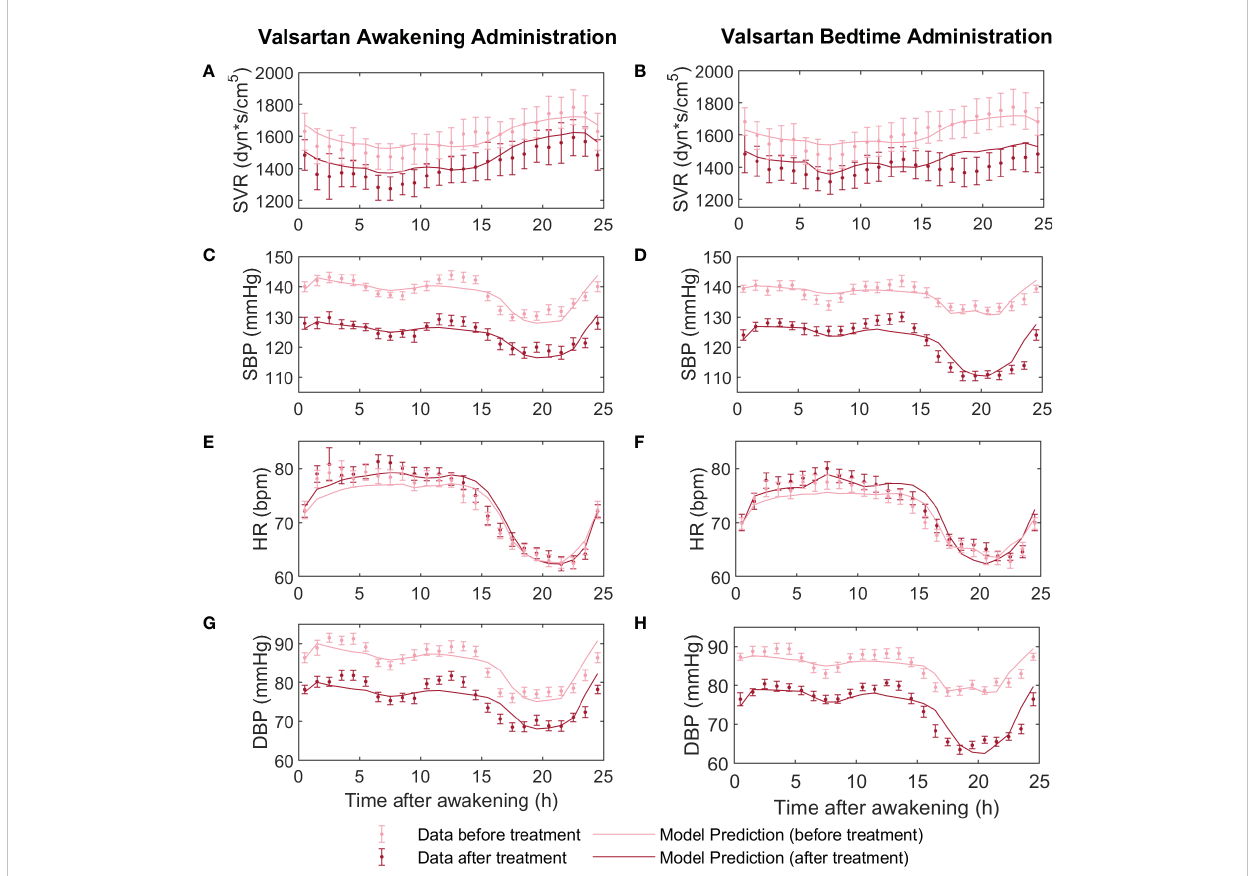
FIGURE 1 Fitting models to data before and after valsartan treatment at awakening (on the left) versus at bedtime (on the right). Before-treatment data from AM and PM administration groups were fi tted independently, to a non-Ta dependent effect model. After-treatment data were fi tted to the Ta- dependent effect model, both awakening and bedtime administration simultaneously. In panels (A, B) the dynamics of the experimental data (light red points for before treatment and dark red points for after treatment) and predictions of the models (light red line for before treatment and dark red line for after treatment) of systemic vascular resistance (SVR), (C, D) systolic blood pressure (SBP), (E, F) heart rate (HR), and (G, H) diastolic blood pressure (DBP) are